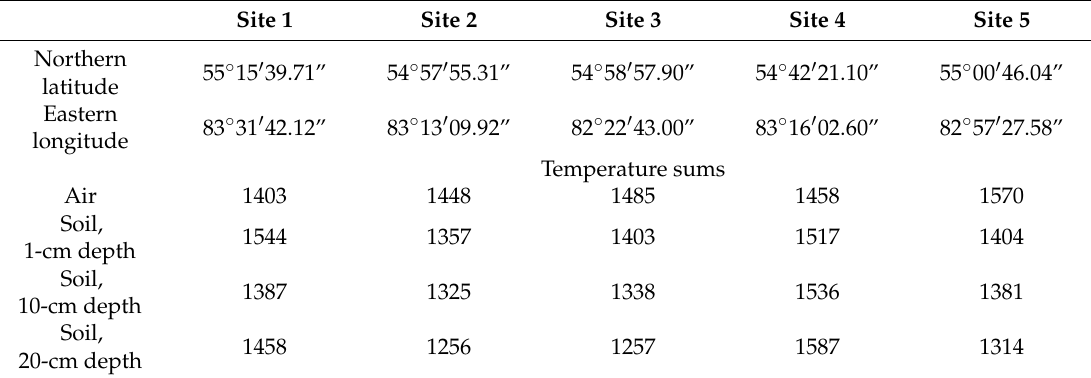
Table 1. The geographical location of experimental sites and their temperature sums ( ◦ C · day) over the growing period.